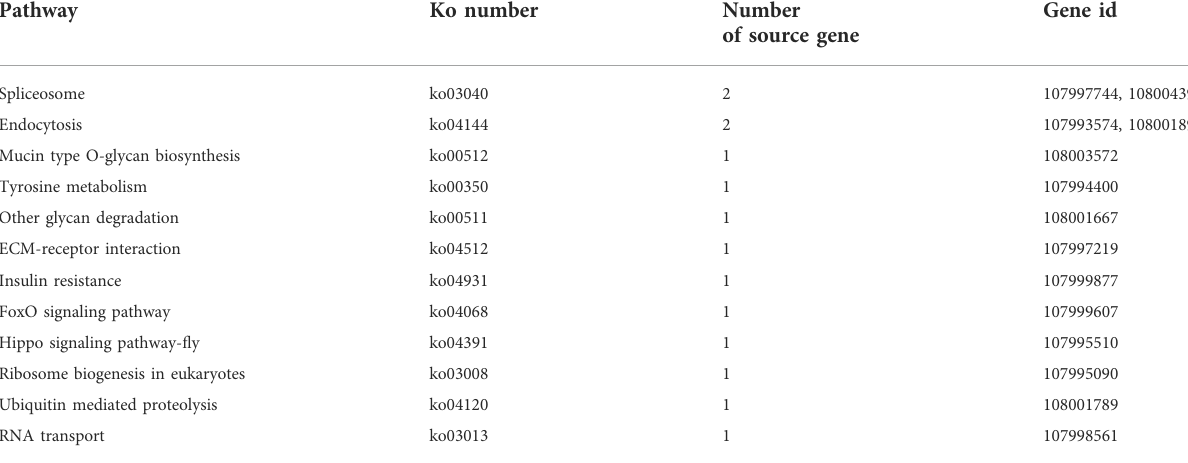
TABLE 2 KEGG pathways enriched by source genes of DEcircRNAs in AcCK1 vs AcT1 comparison